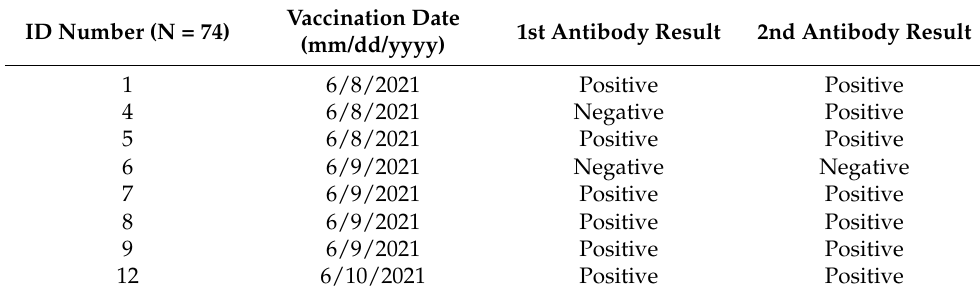
Table 1. List of subjects by ID number, the date of vaccination, and the 1st and 2nd follow-up appointment results of their antibody